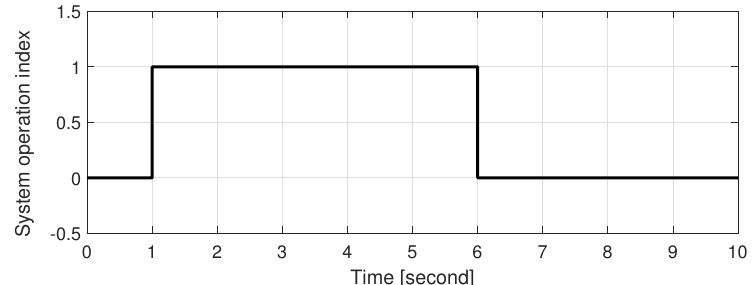
Figure 8. System operation index.